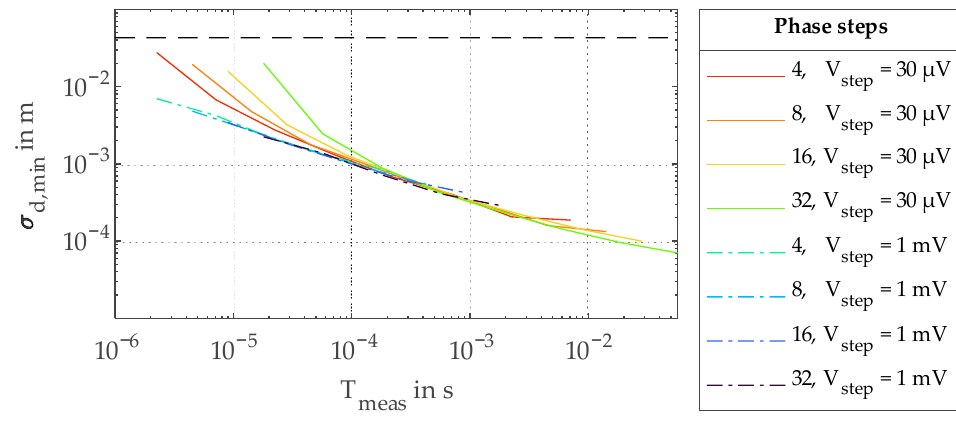
Figure 7. Minimum standard deviation σ d,min over total measurement time T meas .